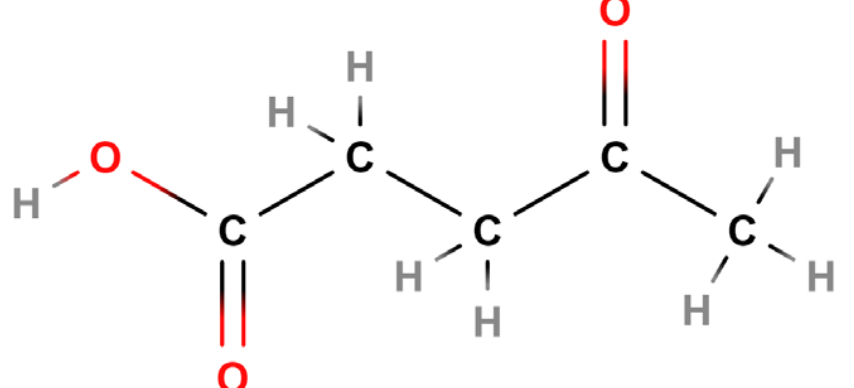
Figure 2. Structure of levulinic acid (C 5 H 8 O 3